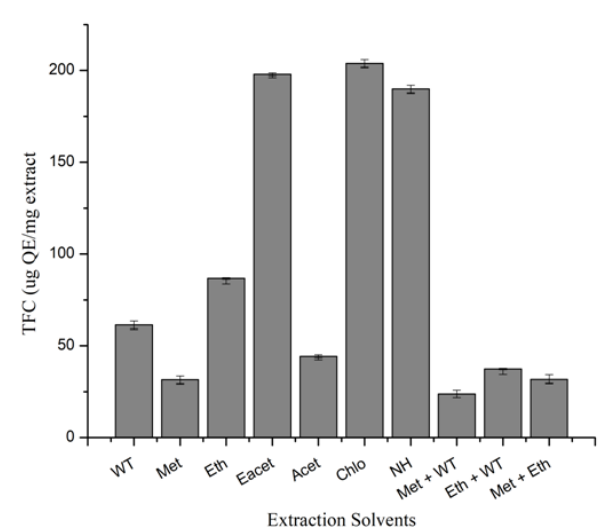
FIGURE 2 - Total Flavonoid content μg/mg extract quercetin equivalent (QE) of E. intermedia. Values obtained are as mean ± Standard error from three separate